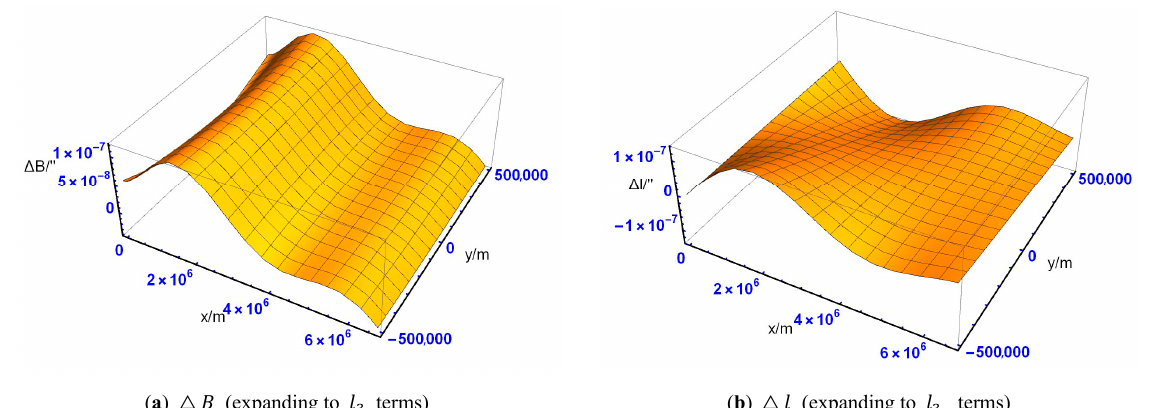
Figure 18. The distribution of ( ∆ B , ∆ l ) when expanding to l 3 terms (based on e ).